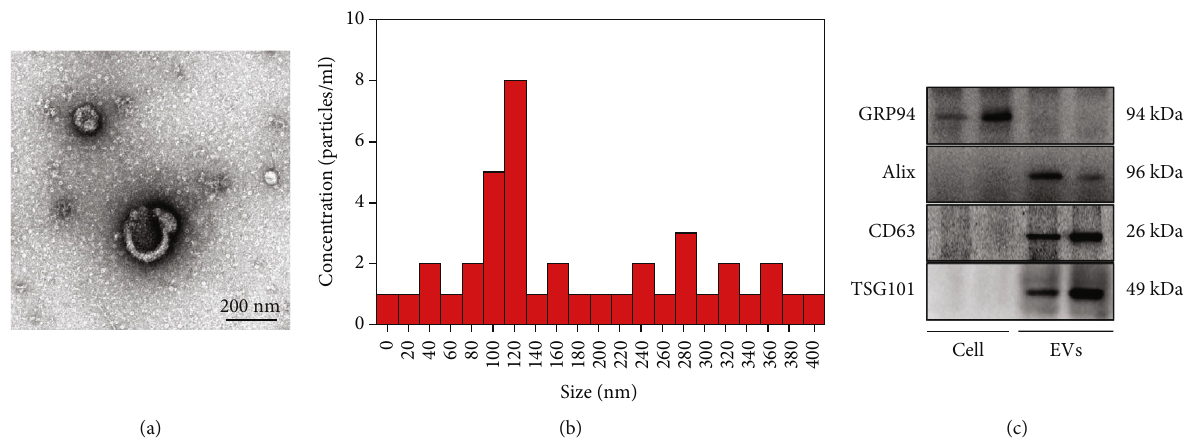
Figure 1: Characterization of hBMSC-EVs: (a) transmission electronic microscopic image of EVs, scale bar = 200 nm; (b) size of EVs determined by NanoSight; (c) protein expression of ALIX, CD63, TSG101, and GRP94 in the isolated hBMSC-EVs determined by Western blot.